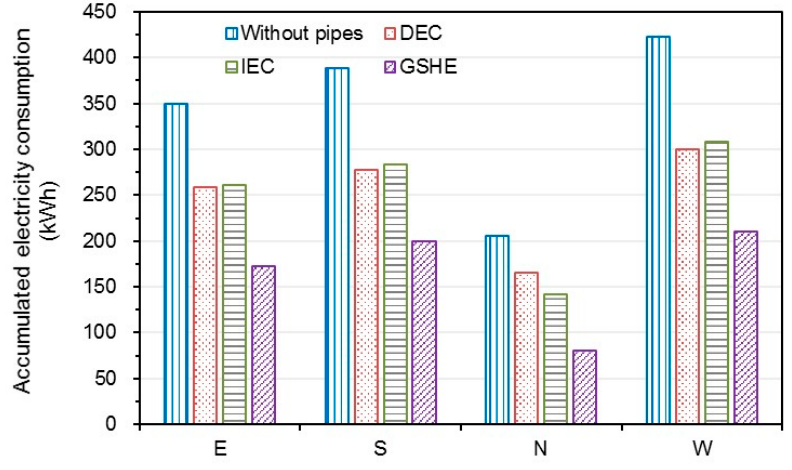
Figure 13. Seasonal electricity consumption of the offices in different orientations.